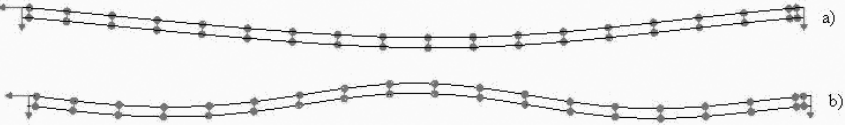
Fig. 11. Desired a) and undesired b) deformation shape for activating the control.